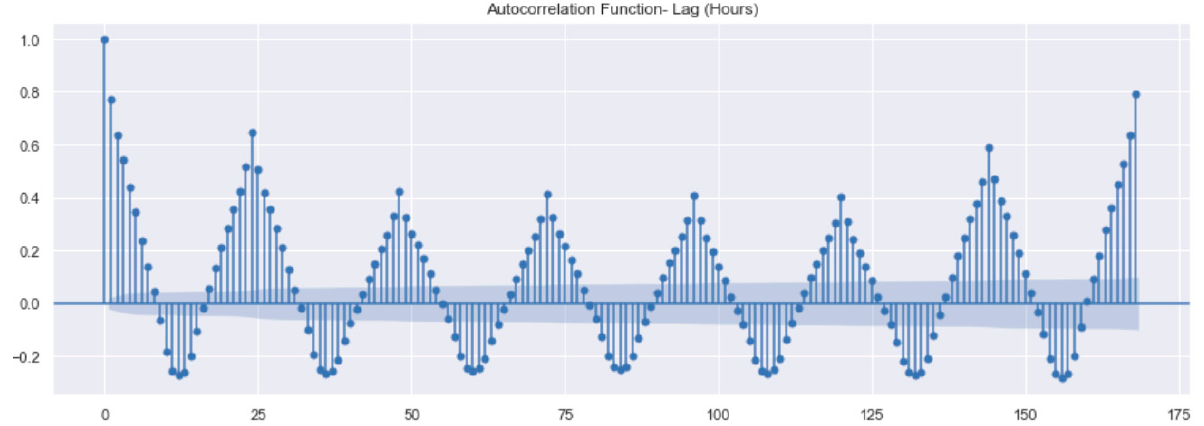
Figure 6. HVAC consumption-ACF plot.